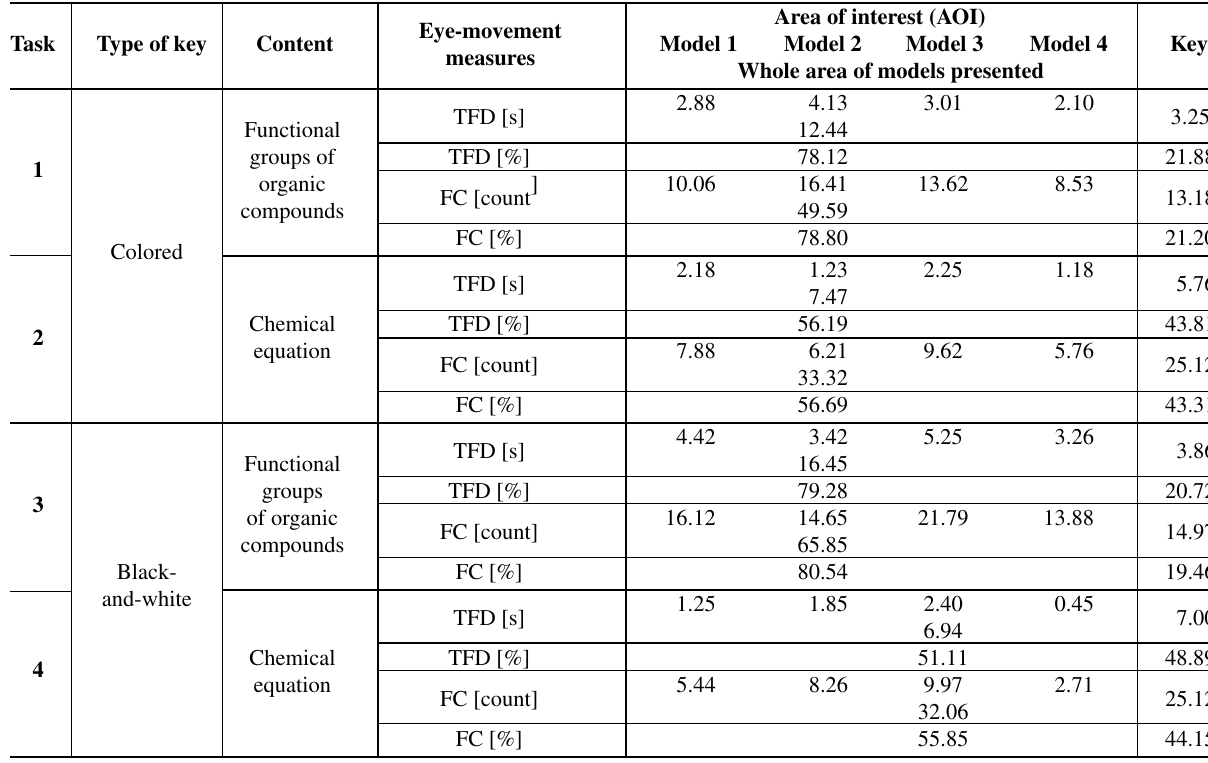
Table 2. Mean values of absolute and relative TFD and FC for tasks 1 to